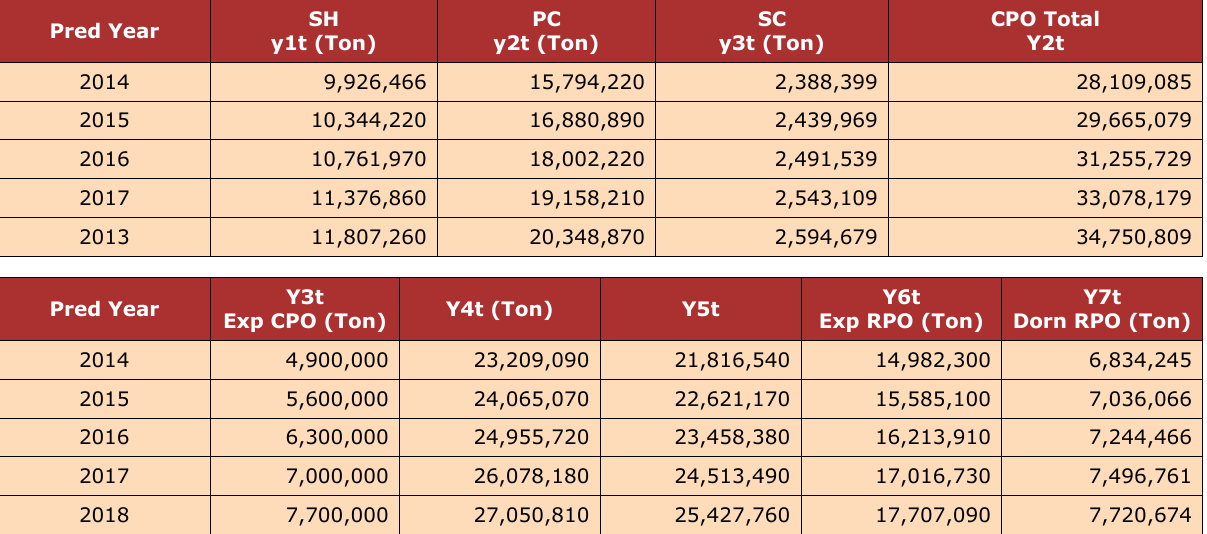
Table 3. Model Output: Subprocesses